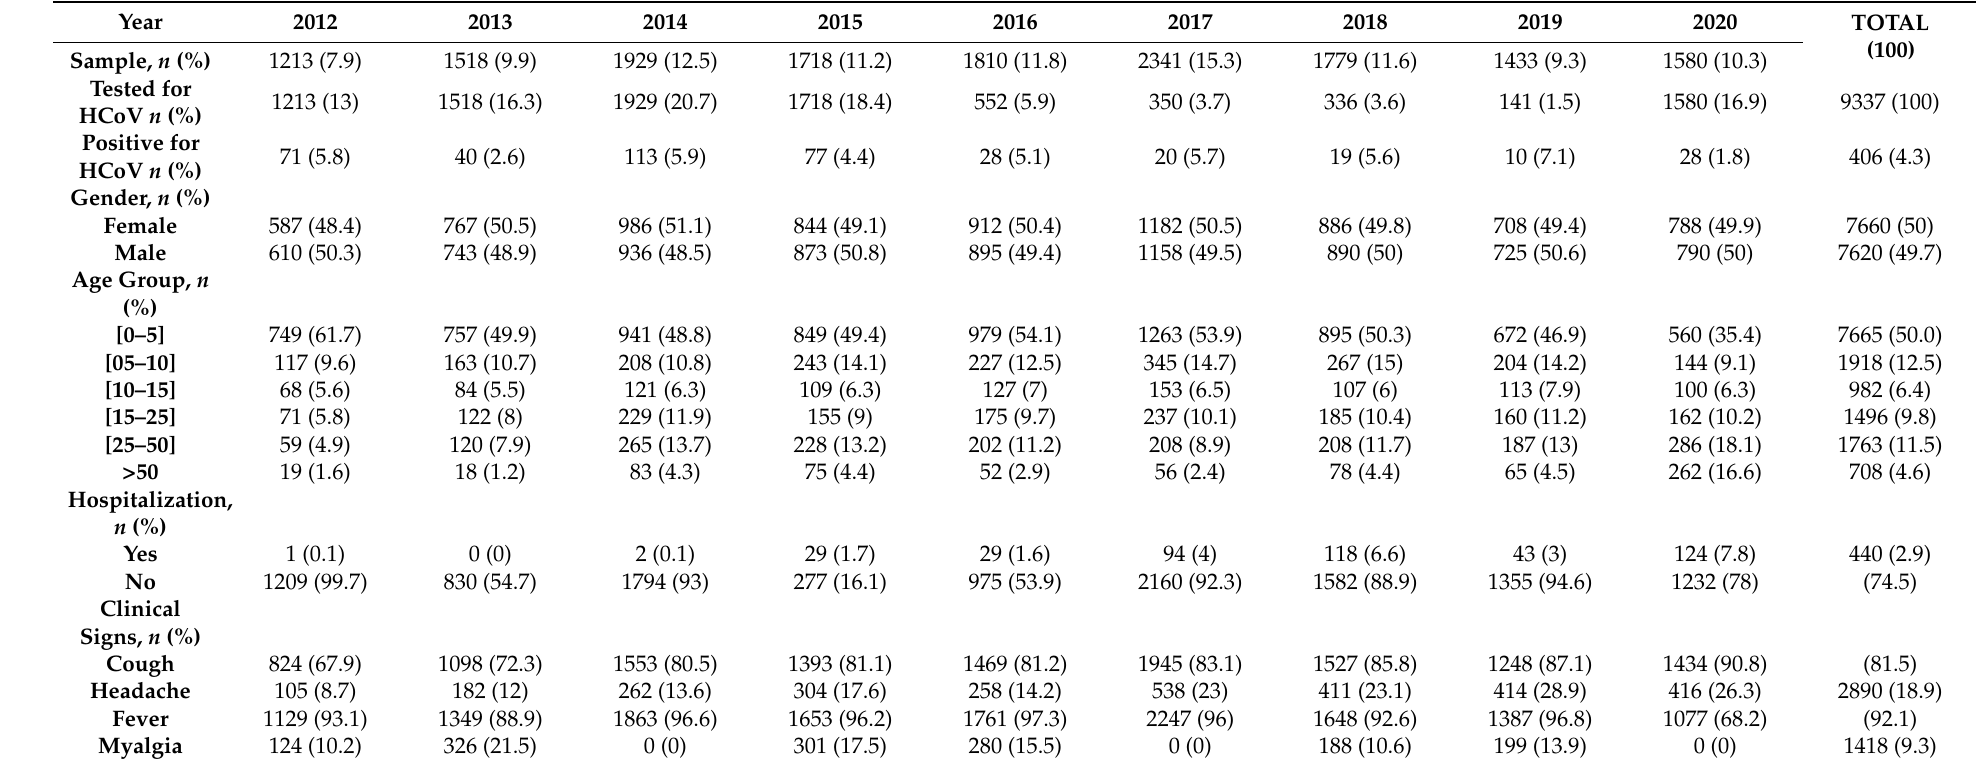
Table 1. Clinical and demographic characteristics of the patients with ILI/SARI in Senegal,